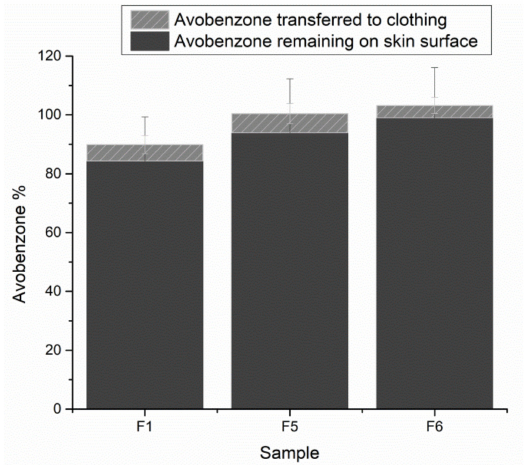
Figure 5. In vivo substantivity test depicting the ratio of the model active substance fixed on the skin within the generated film vs. the one transferred to the volunteers’